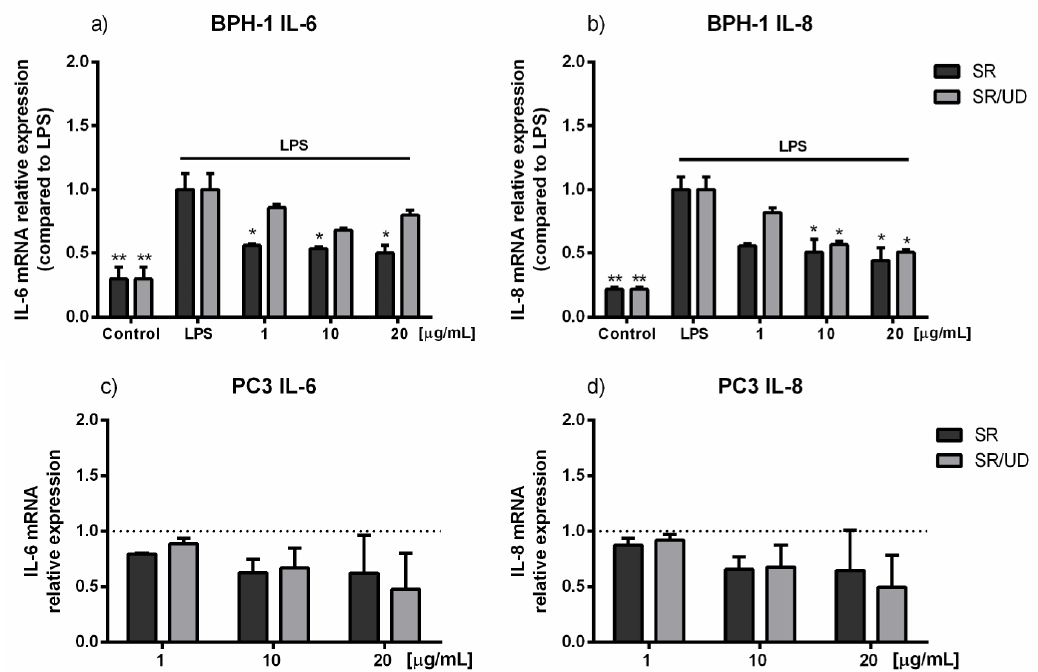
Figure 4. E ff ect of SR and SR / UD (1, 10, 20 µ g / mL) on IL-6 and IL-8 mRNA expression in BPH-1 and PC3 cells. ( a ) IL-6 expression in BPH-1 cells pre-treated with SR and SR / UD for 48 h and stimulated with LPS (10 µ g / mL) for 24 h. ( b ) IL-8 expression in BPH-1 cells pre-treated with SR and SR / UD for 48 h and stimulated with LPS (10 µ g / mL) for 24 h ( c ) IL-6 expression in PC3 cells treated with increasing concentrations of SR and SR / UD for 72 h. ( d ) IL-8 expression in PC3 cells treated with increasing concentrations of SR and SR / UD for 72 h. IL-6 and IL-8 were evaluated by qPCR. IL-6 and IL-8 are expressed as the ratio between treatments and LPS stimulus * p < 0.05, treatment compared to LPS, ** p < 0.01, Control compared to LPS. Data represent the mean ± SEM ( n =